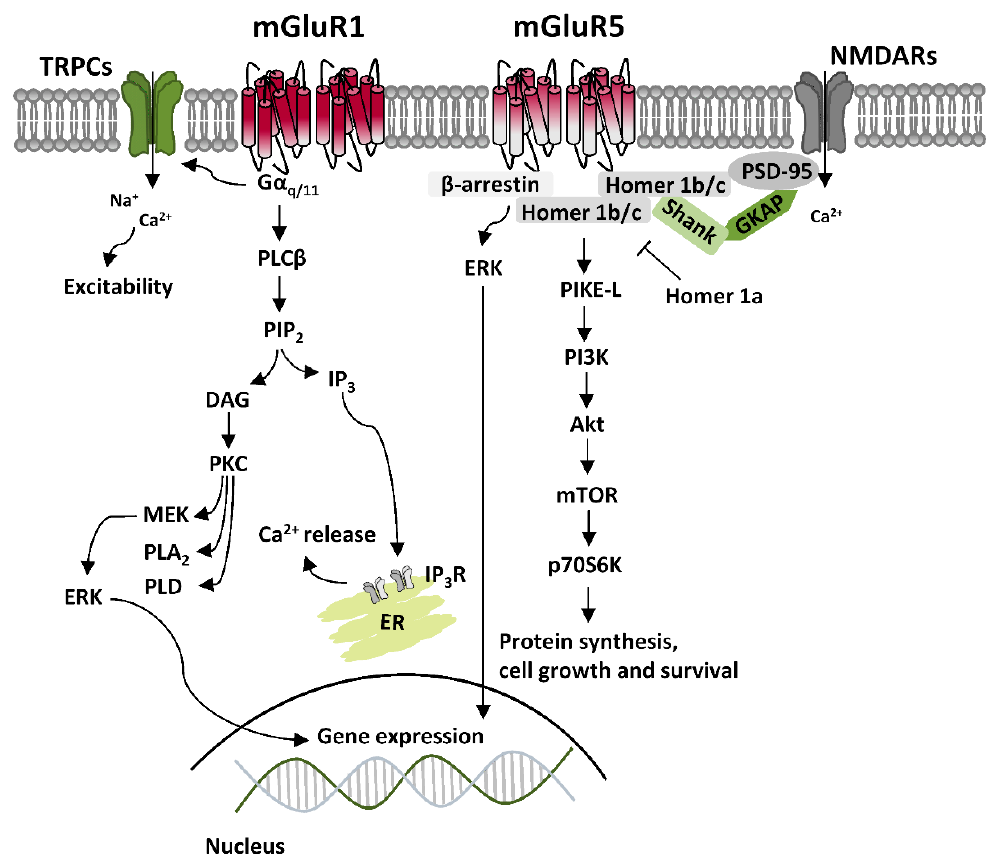
Figure 1. Group 1 metabotropic glutamate receptors (mGluRI) signaling. Scheme of the principal signaling pathways downstream to mGluR1 and mGluR5, showing G q / 11 -dependent activation of phospholipase C β (PLC β ), which mediates the hydrolysis of phosphatidylinositol and generation of inositol-1,4,5-trisphosphate (IP 3 ) and diacylglycerol (DAG), that fosters Ca 2 + intracellular mobilization from internal stores. Protein kinase C (PKC), also activated by DAG, is involved in the stimulation of extracellular signal-regulated kinase (ERK), a ff ecting gene expression. mGluR1 / 5,